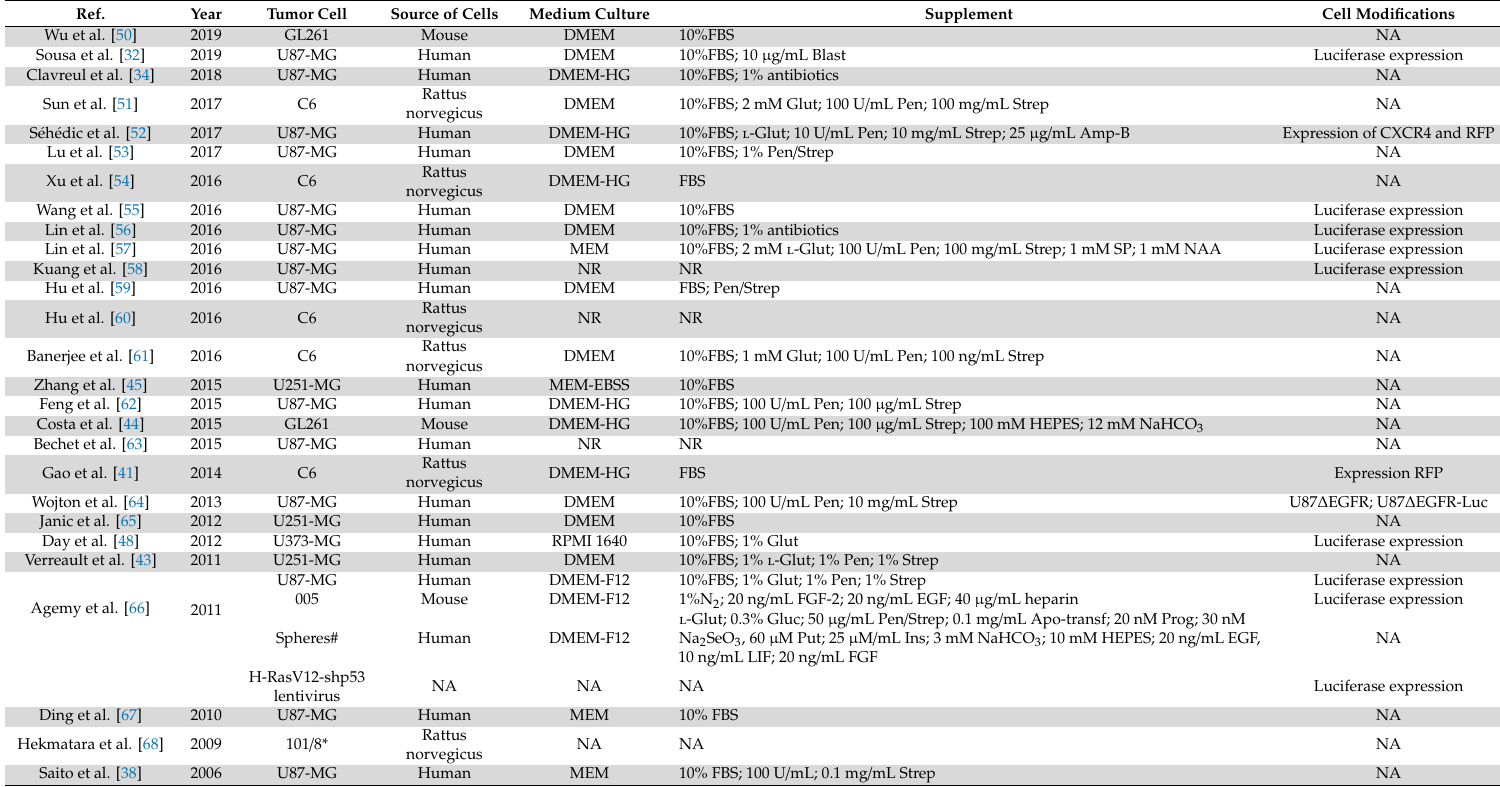
Table 1. Cell characteristics of glioblastoma